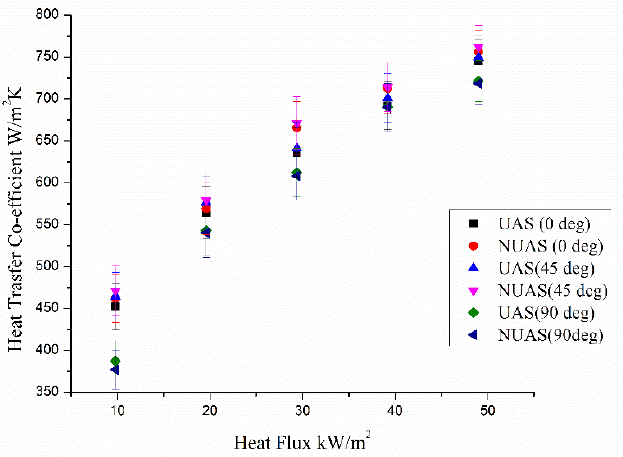
Figure 7. Heat transfer co-efficient on various setting angles on UAS and